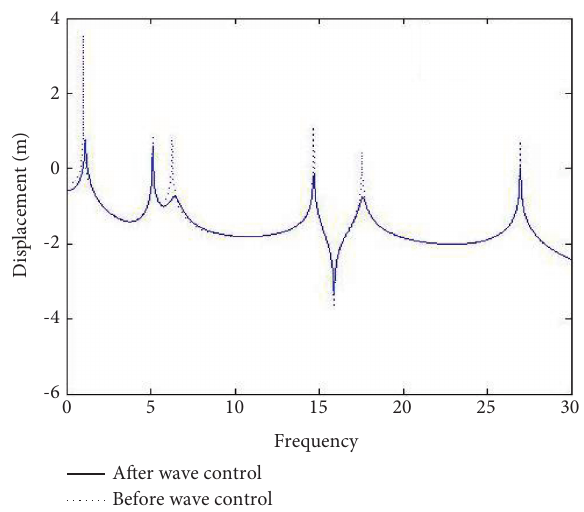
Figure 3: Frequency response before and after wave control.